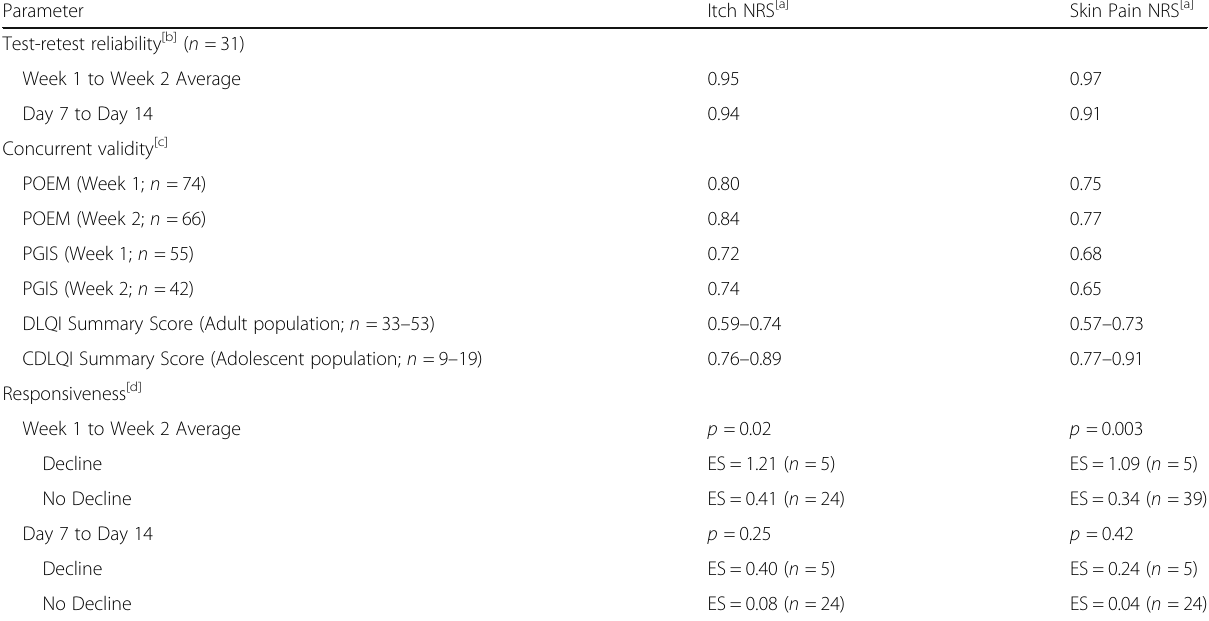
Table 3 Results of Psychometric Analysis of Real-World Daily eDiary Data Parameter